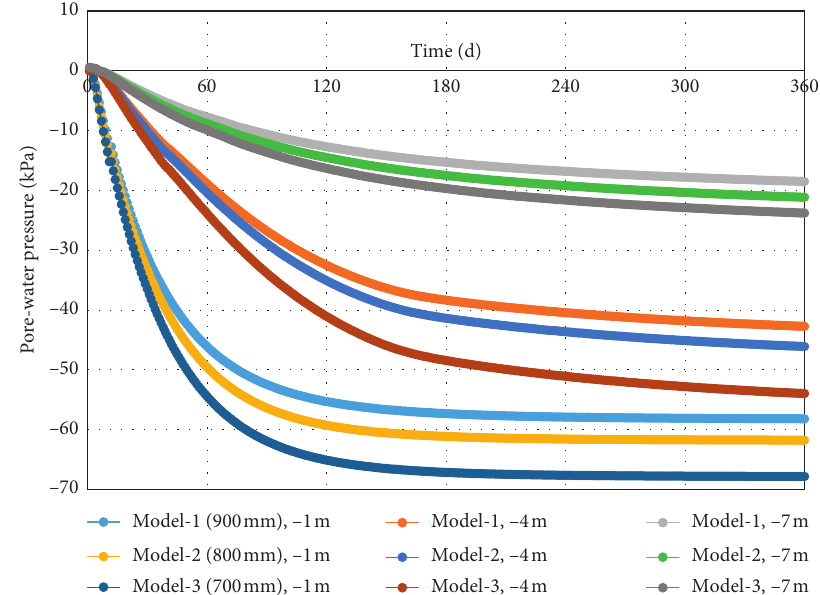
Figure 15: Pore pressure from different computational